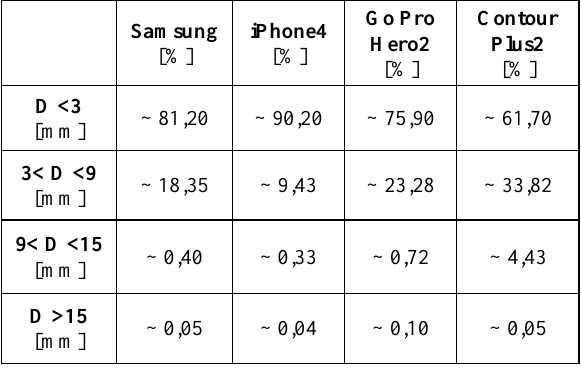
Table 4 – Percentage of differences between the laser mesh Figure 10 - Comparison between laser model and iPhone meshes